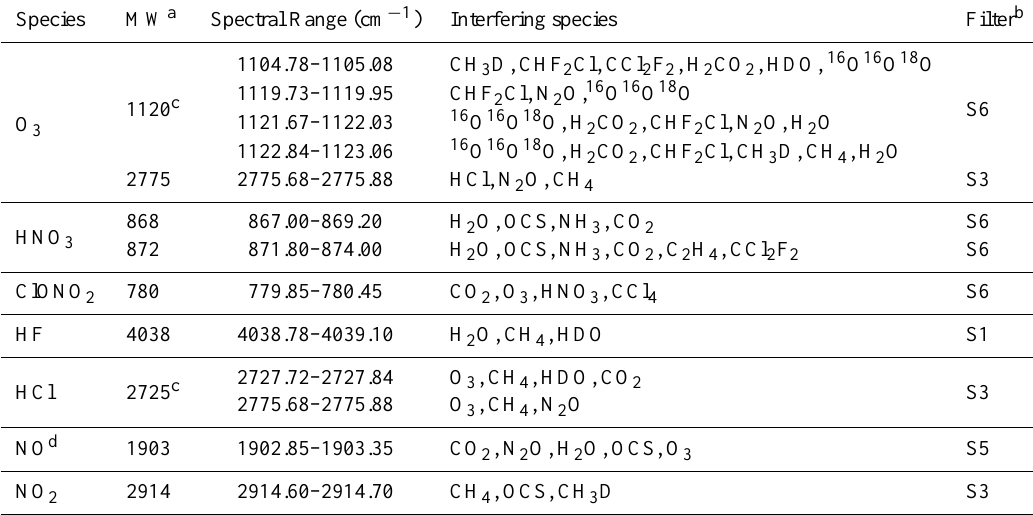
Table 1. Species, spectral ranges of microwindows, interfering species, and filters used in ground-based